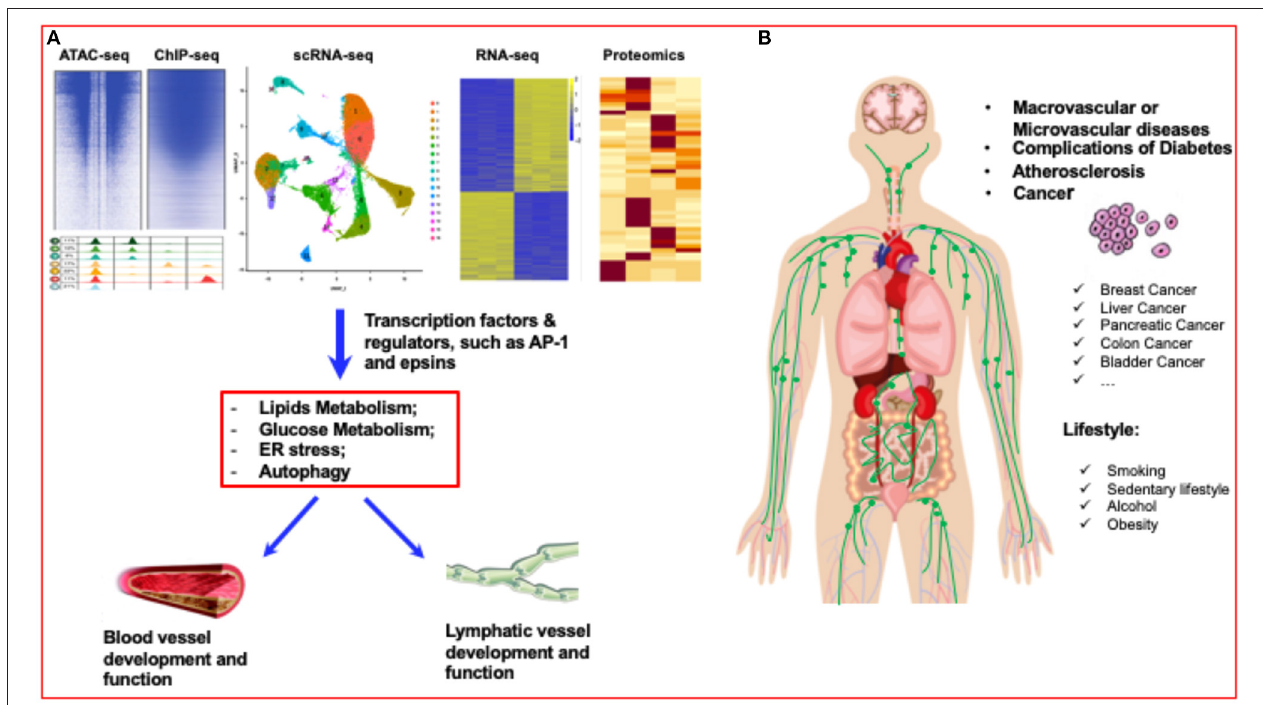
FIGURE 1 | Diabetes research has entered a new era of single-cell biology. (A) Single-cell analysis has entered the multiomics age. By using multiomics single-cell analysis, such as ATAC-seq, ChIP-seq, scRNA-seq, RNA-seq and proteomics analysis, the transcriptome factors or regulators of blood vessels and lymphatic vessels can be accurately identified. (B) Lifestyles, such as smoking, sedentary lifestyle, alcohol, and obesity can significantly affect the vascular diseases, such as atherosclerosis, diabetes, even including different